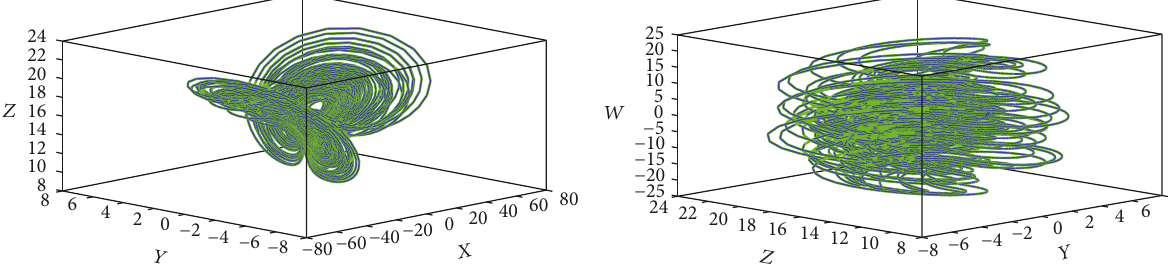
Figure 11: 3D phase portraits of NCS ( 𝑎 ̸= 0, 𝑏 ̸= 0 ).